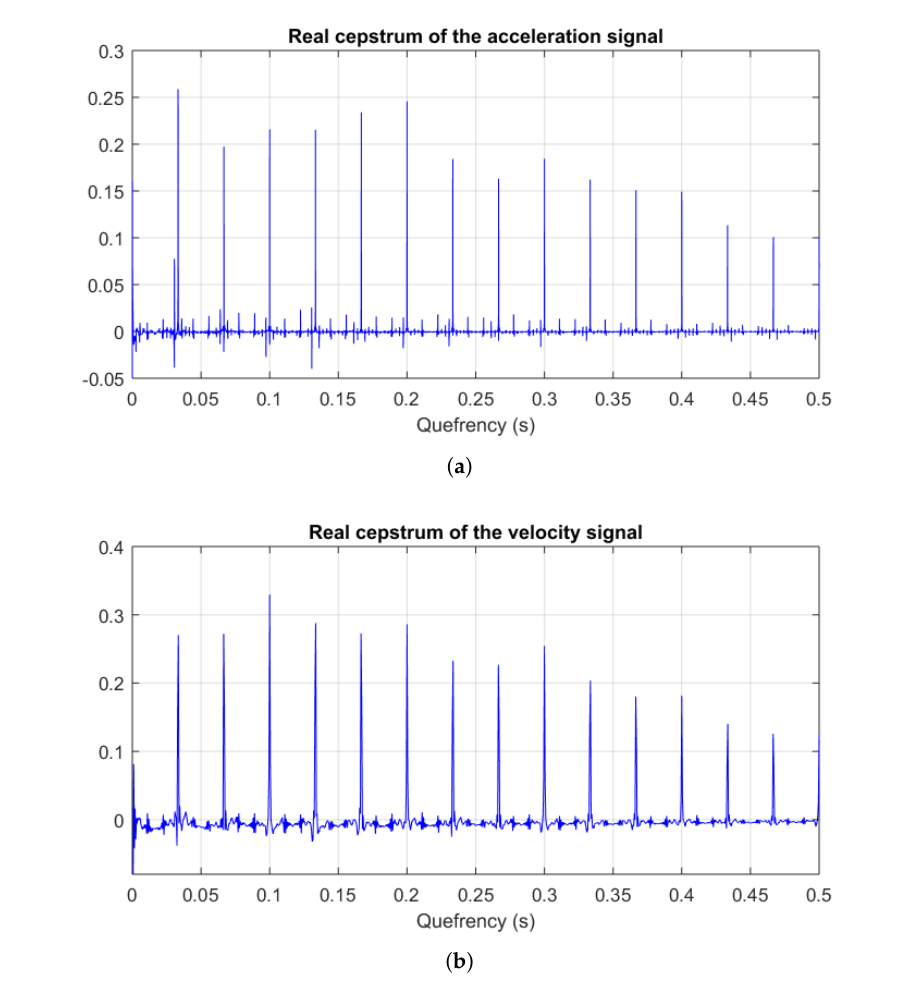
Figure 11. Real cepstra of the accelerometer signals with single-point rub: ( a ) acceleration signal; and ( b ) velocity